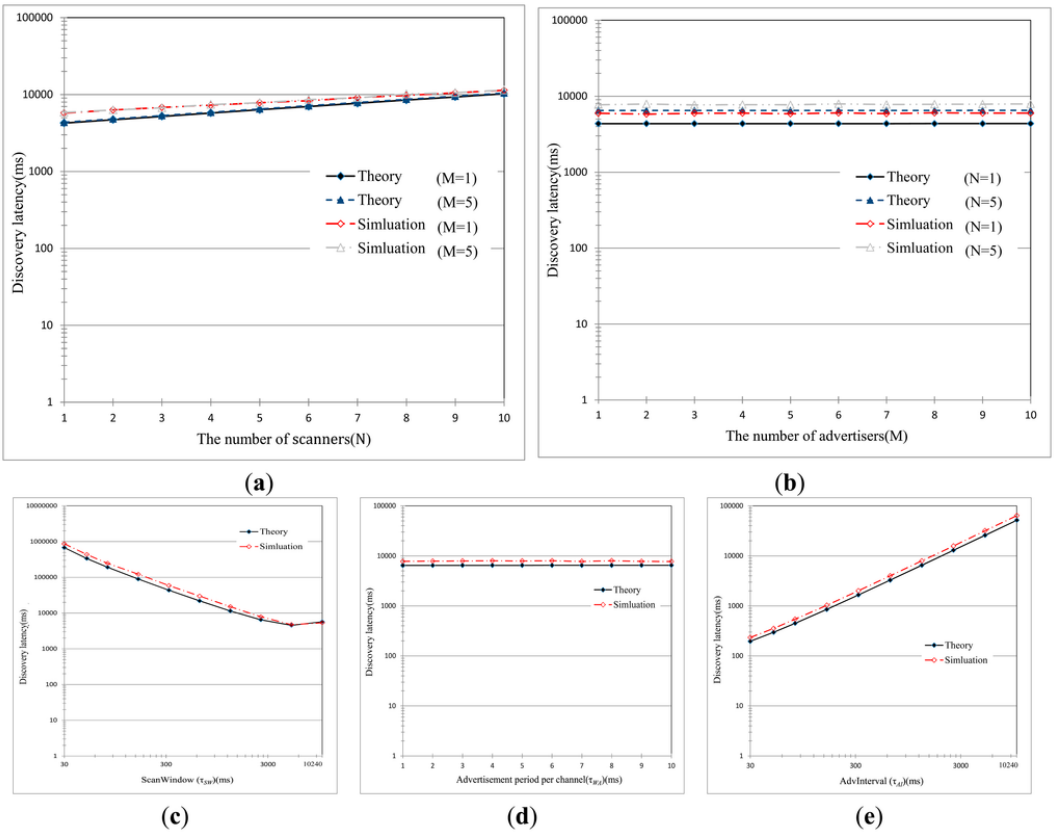
Figure 24. Mean discovery latency with various parameter settings. ( a ) The mean discovery latency as the number of scanners is increased ( τ SI = 10,240, τ SW = 2560, τ WA = 10, τ AI = 1280); ( b ) the mean discovery latency as the number of advertisers increases ( τ SI = 10,240, τ SW = 2560, τ WA = 10, τ AI = 1280); ( c ) the mean discovery latency as ScanWindow ( τ SW ) is varied ( τ SI = 10,240, τ WA = 10, τ AI = 1280, M = 5, N = 5); ( d ) the mean discovery latency as τ WA is varied ( τ SI = 10,240, τ SW = 2560, τ AI = 1280, M = 5, N = 5); ( e ) the mean discovery latency as AdvInterval ( τ AI ) is varied ( τ SI = 10,240, τ SW = 2560, τ WA = 10, M = 5, N = 5). τ SI is the scanInterval ; τ SW is the ScanWindow ; τ AI is the advInterval ; M is the number of advertiser ; N is the number of scanners . Adapted from